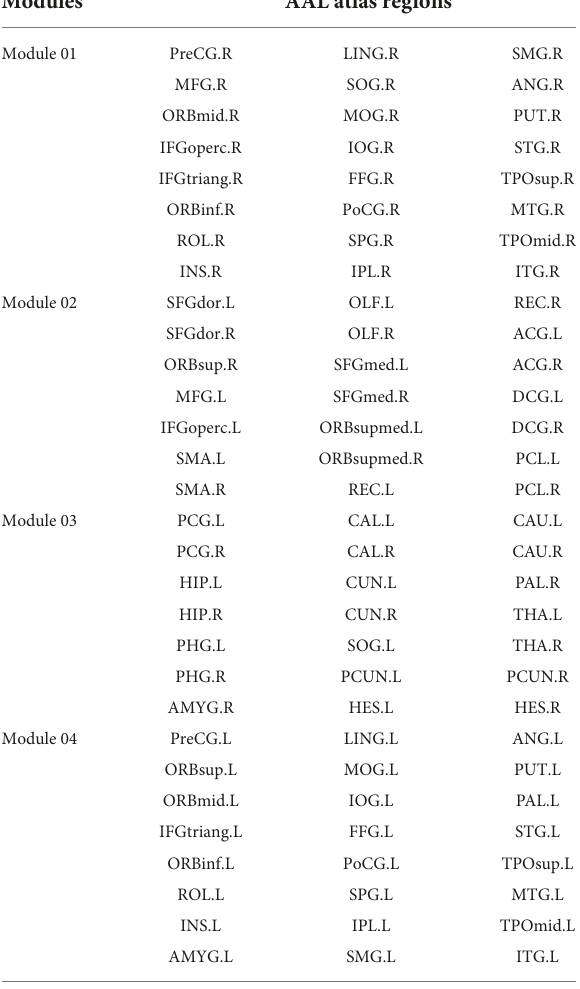
TABLE 3 The detailed information on four modular